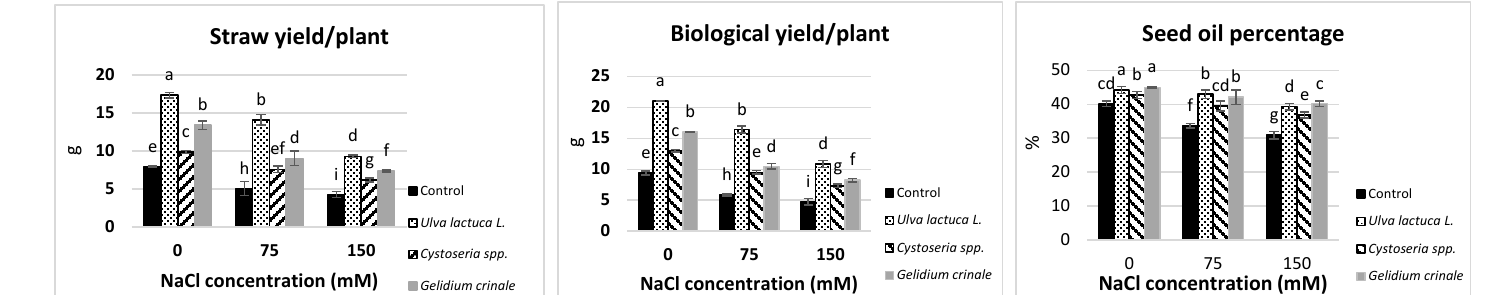
Figure 1. The impact of Ulva lactuca L., Cystoseria sp., and Gelidium crinale soil treatment on the yield and seed oil percentage of canola plants grown under different levels of salinity. Data are presented as the mean ± SD ( n = 50). Straw yield/plant = dry matter of a plant without seeds. The biological yield refers to the total dry matter accumulation of a plant (straw yield + weight of seeds). Different letters indicate significant differences based on a comparison of means with Duncan’s multiple range test at p < 0.05.